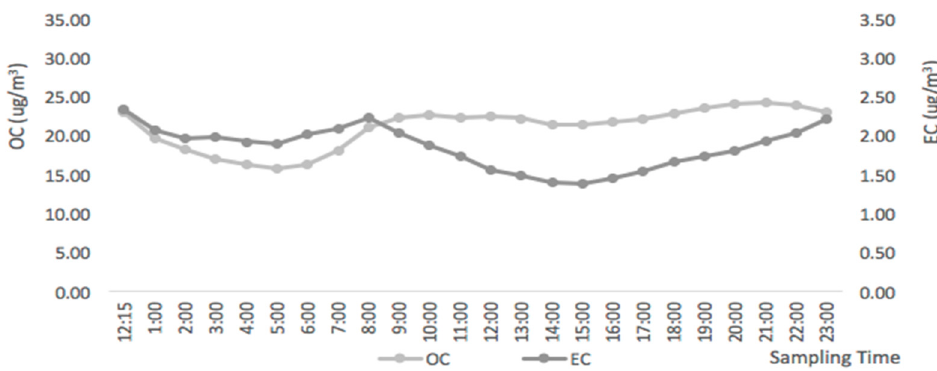
Figure 2. Annual variations of OC and EC concentration.